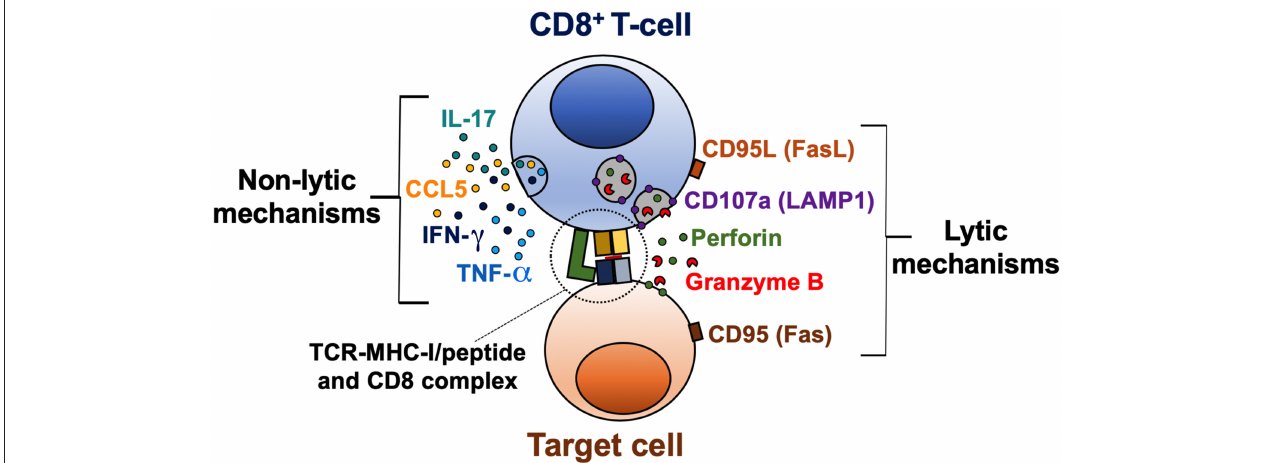
FIGURE 1 | Lytic and non-lytic effector mechanisms of CD8 + T-cells. CD8 + T-cells are activated after recognition of an MHC-I/peptide complex, which binds to the TCR and CD8 molecules. The cytotoxic potential of CD8 + T-cells is determined by the expression of cytotoxic molecules granzyme B and perforin, and a coordinated degranulation process, which can be evaluated by the cell membrane expression of CD107a (LAMP1). Receptor-mediated cell death via CD95L/CD95 interaction is also a lytic mechanism of CD8 + T-cells. Activated CD8 + T-cells can also produce cytokines such as IFN- γ , TNF- α , and IL-17, and the β -chemokine CCL5, which exert a variety of antiviral, inflammatory, and regulatory functions.